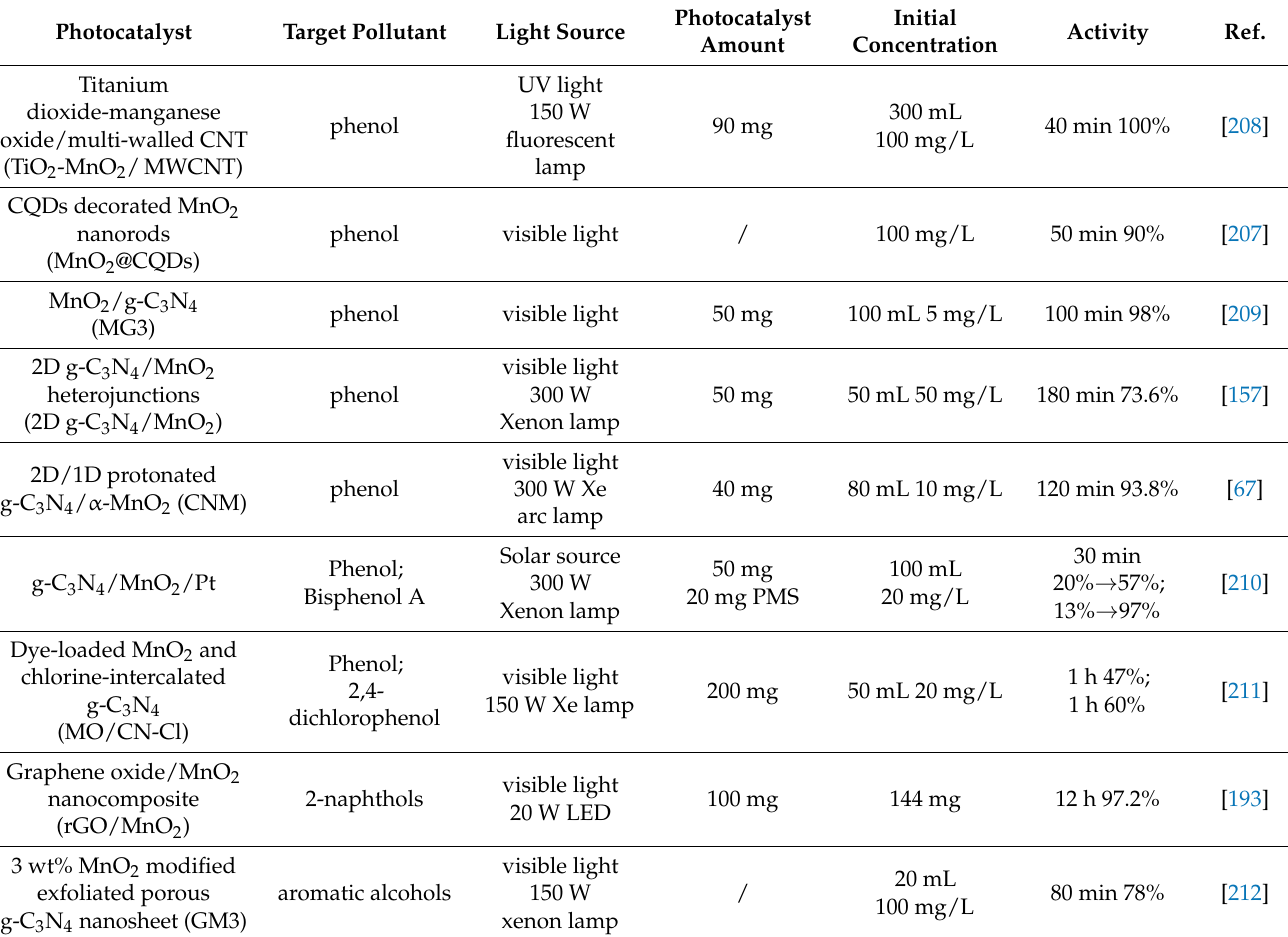
Table 2. Study on MnO 2 -carbon materials for photocatalytic degradation of phenolic compounds in aqueous